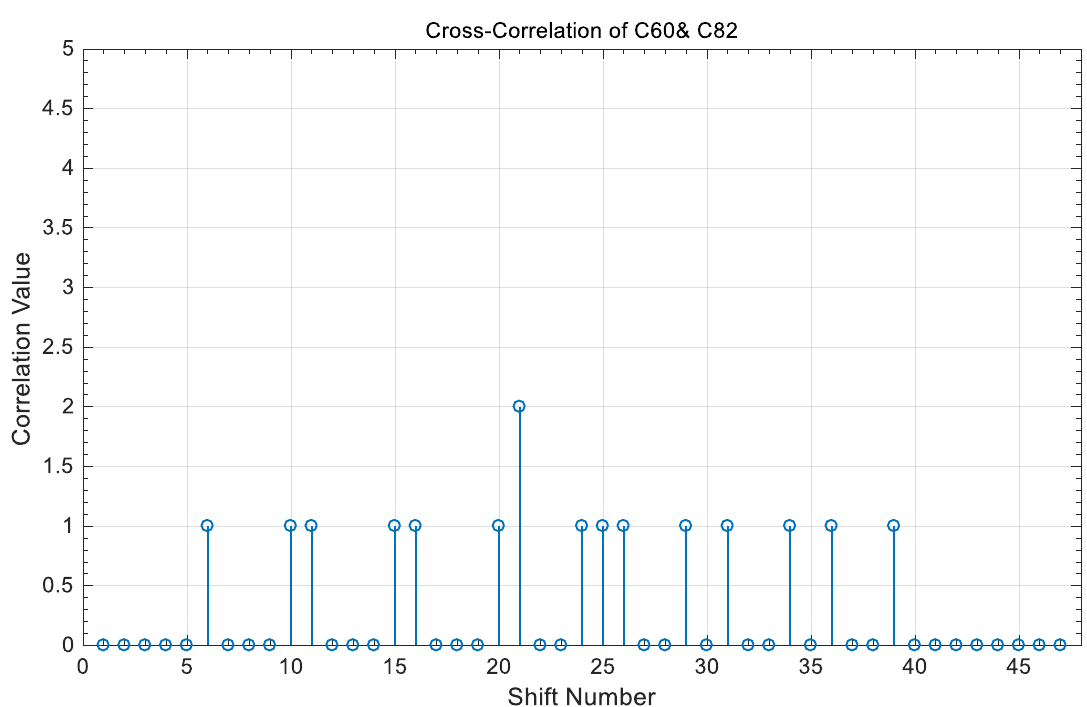
Figure 16. Cross-correlation between 𝐶 60 and 𝐶 82 sequences from different groups, 𝑃 1 = 5 and 𝑃 2 = 7 .